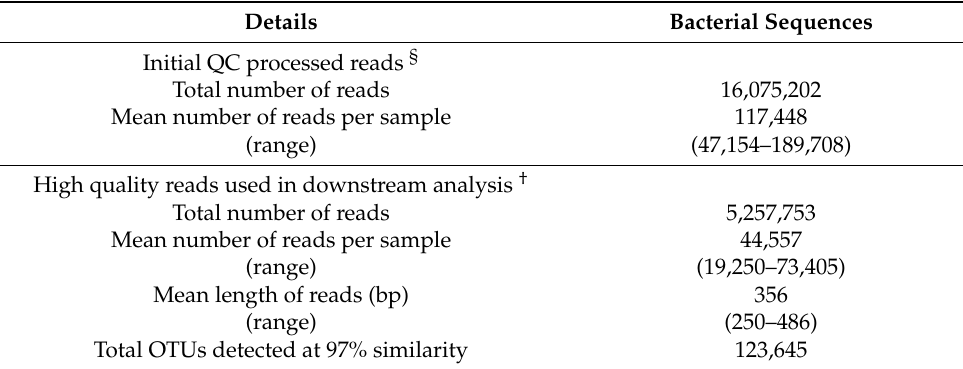
Table 2. Metrics of sequencing and quality